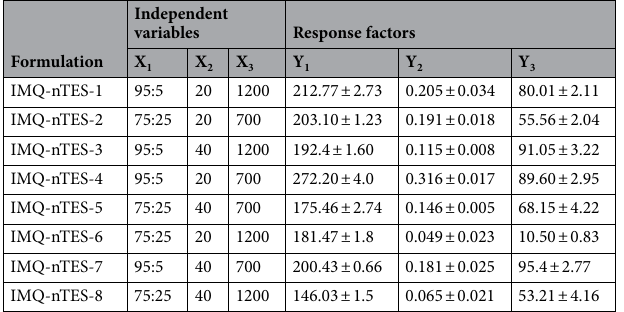
Table 2. Composition, independent variables, and response factors of 8 IMQ-nTES formulations, generated by 2 3 factorial design using DESIGN EXPERT. All values are mentioned as mean ± S.D (n =